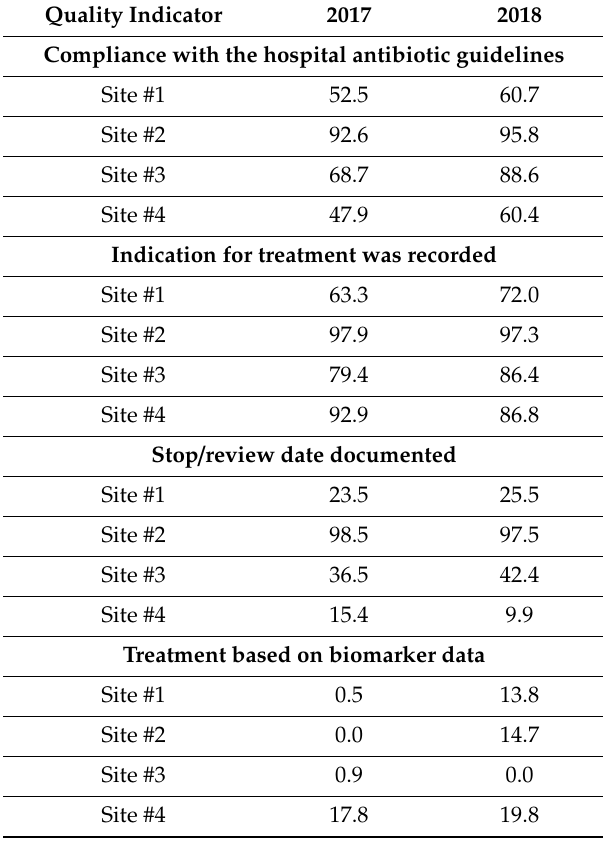
Table 6. Quality indicators of systemic AMD prescribing in four hospital sites with repetitive PPS in 2017 and 2018,